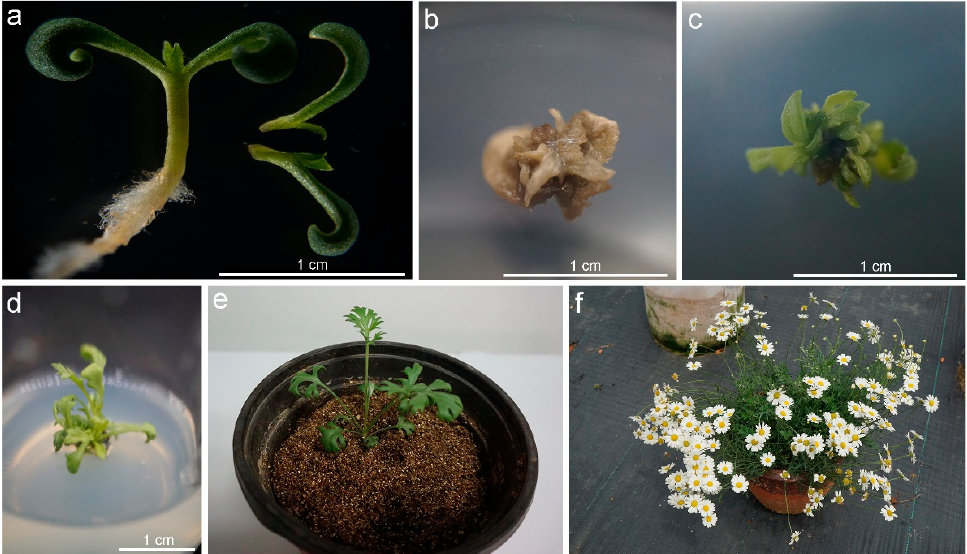
Figure 2. Induction of transgenic proTcCHS-GUS plants from pyrethrum shoot apical meristems. ( a ) Seedlings of pyrethrum were germinated in sterile conditions and seedling shoot tips were cut in half longitudinally. ( b ) After 4 weeks of selective culture, nontransformed shoots turned brown. ( c ) After 4 weeks of selective culture, transformed explants formed kanamycin-resistant shoots. ( d ) Kanamycin-resistant shoots were transferred to root-induction medium for 1 month. ( e ) Rooted shoots were transferred to sterile vermiculite for 30 d. ( f ) Adapted plants were transferred to soil for 1 year. Scale bar = 1.0 cm.